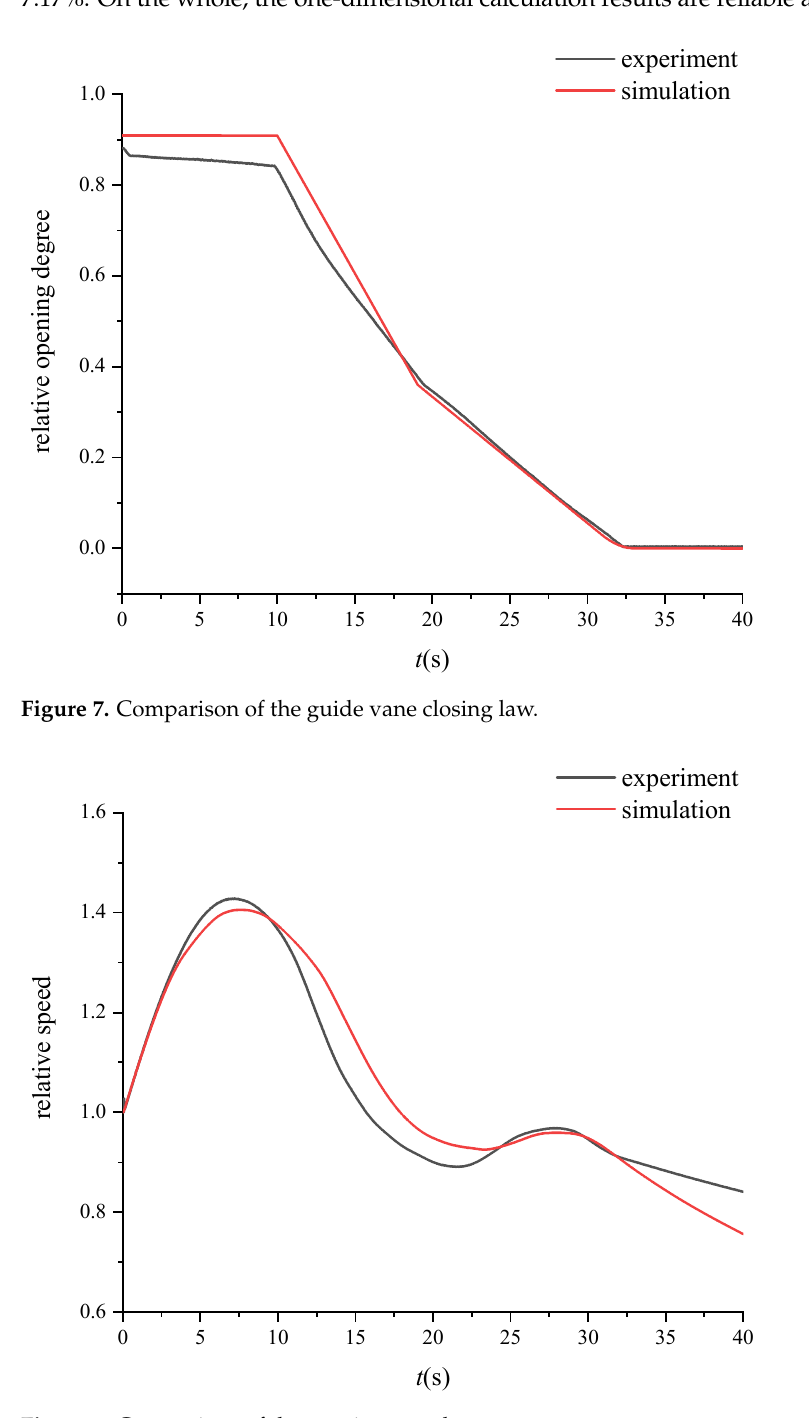
Figure 8. Comparison of the rotating speed.